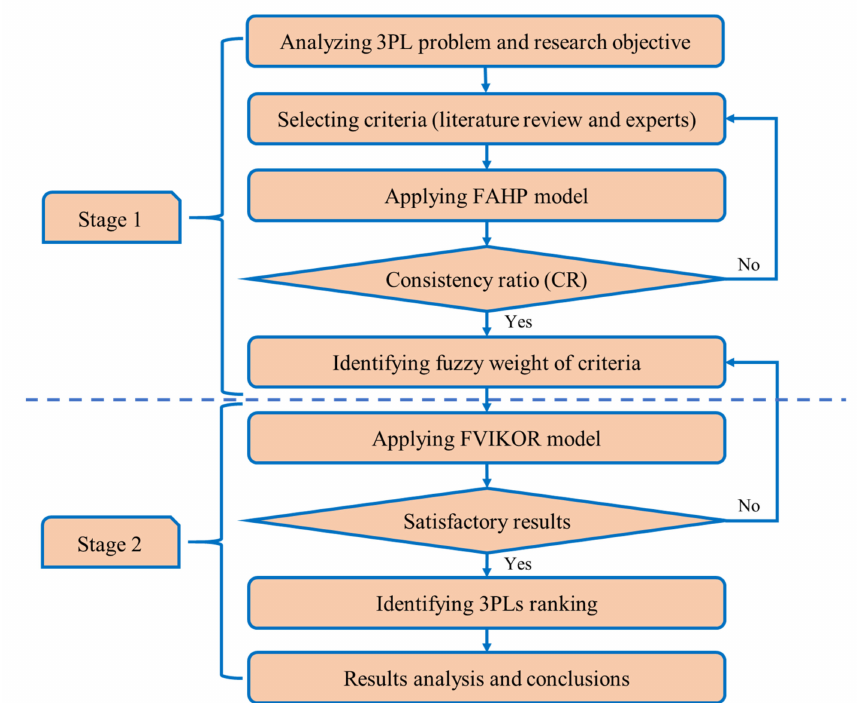
Figure 1. Research flowchart.